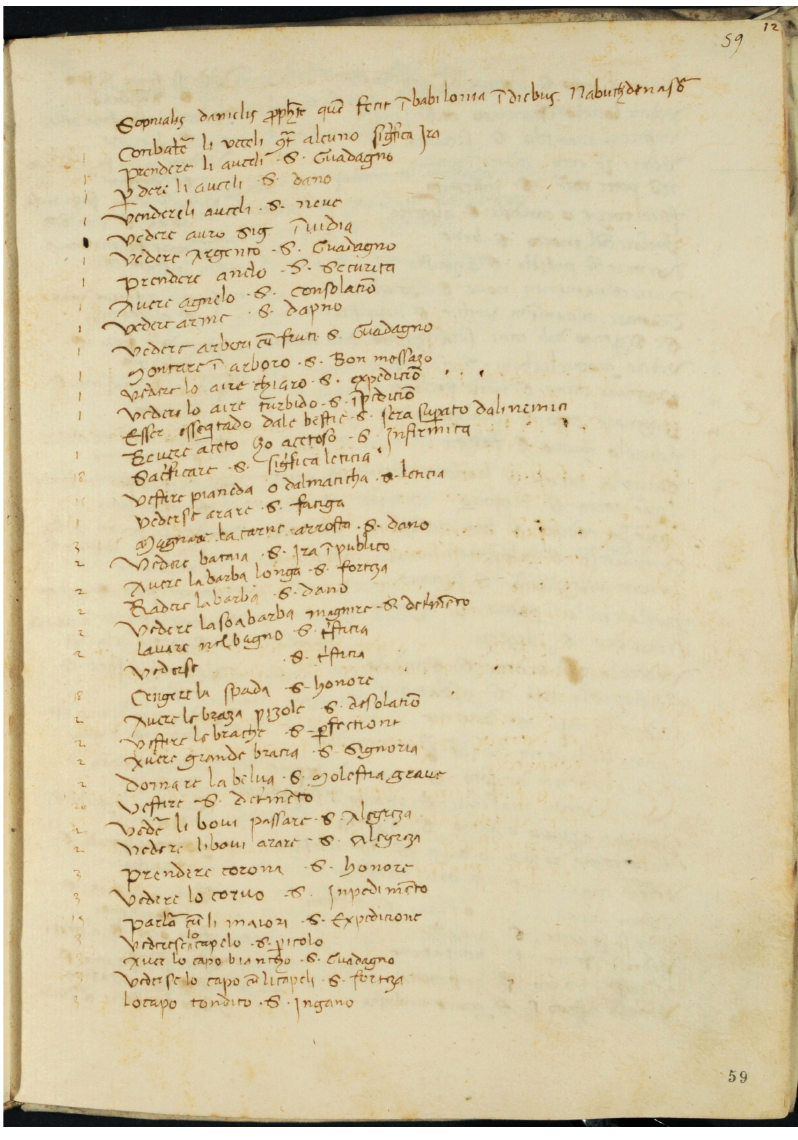
Fig. 4: Florence, Biblioteca Riccardiana, MS 859, fol. 59r, courtesy of the Ministry of Cultural Heritage and Activities and Tourism. Further reproduction by any means is